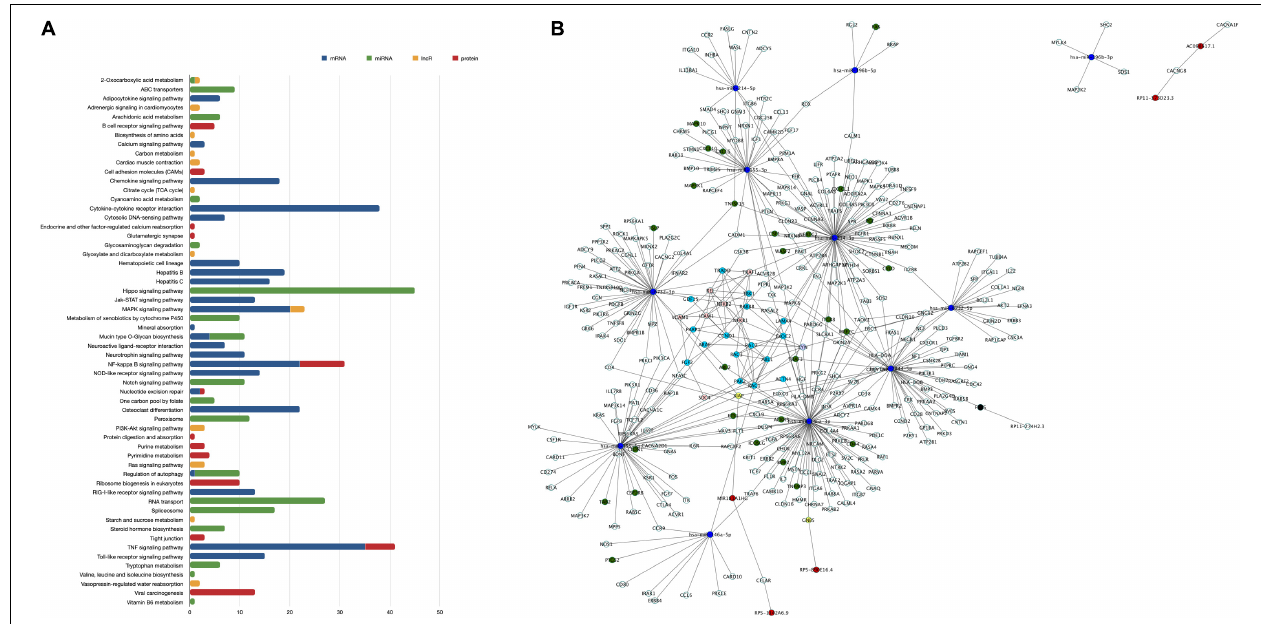
FIGURE 2 | Enriched pathways of differentially expressed transcripts and proteins of human brain microvascular endothelial cells treated with TNF- α vs. control. Differentially expressed transcripts and proteins between study groups were used in a GeneTrial analysis to obtain the list of enriched pathways. Subsequently, a set of genes involved in KEGG endothelial pathway functions was used to map against our differentially expressed transcripts and proteins. (A) Histogram that shows the number of transcripts and proteins mapped to the enriched pathways. The blue bars represent the enriched pathways of mRNAs, the green bars of miRNAs, the yellow bars of lncRNAs and the red bars of proteins. (B) Network of interactions between mRNAs, miRNAs, and targets, lncRNAs and targets, protein-protein interactions related to a set of genes involved in endothelial cell functions. Node colored labels. Red-lncRNAs, blue marine-miRNAs, green-miRNAs targets and mRNAs DE, yellow-lncRNA and miRNA targets and mRNA no DE, melon-proteins and mRNA DE, clear purple-proteins and mRNAs DE and regulated by miRNAs or lncRNAs, blue clair-proteins and mRNAs no DE, black-miRNA and lncRNA target and mRNA DE, white-miRNA target or lncRNA target and mRNA no DE. DE, differentially